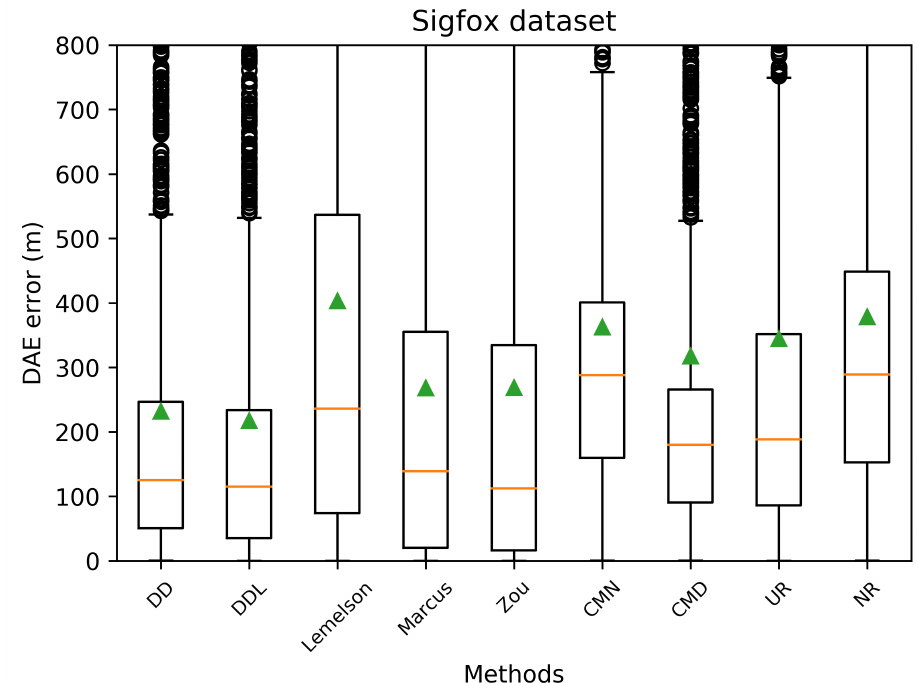
Figure 3. Boxplots indicating the distribution of the absolute DAE error of all studied methods and baselines, in the validation set of the Sigfox dataset. The green triangles indicate the mean values while outliers are depicted as black circles.